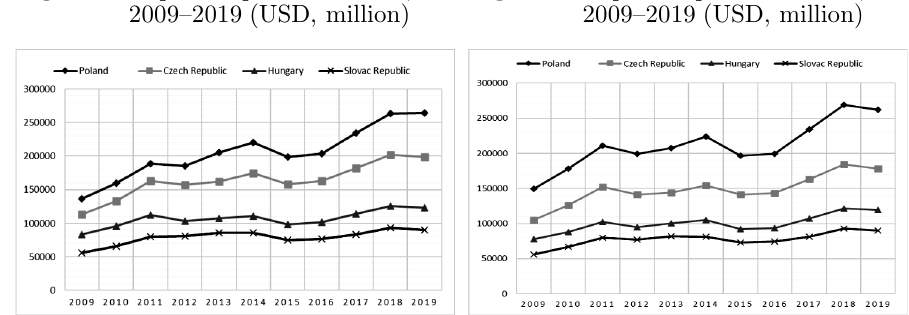
Figure 1. Export of products in V4, Figure 2. Import of products in